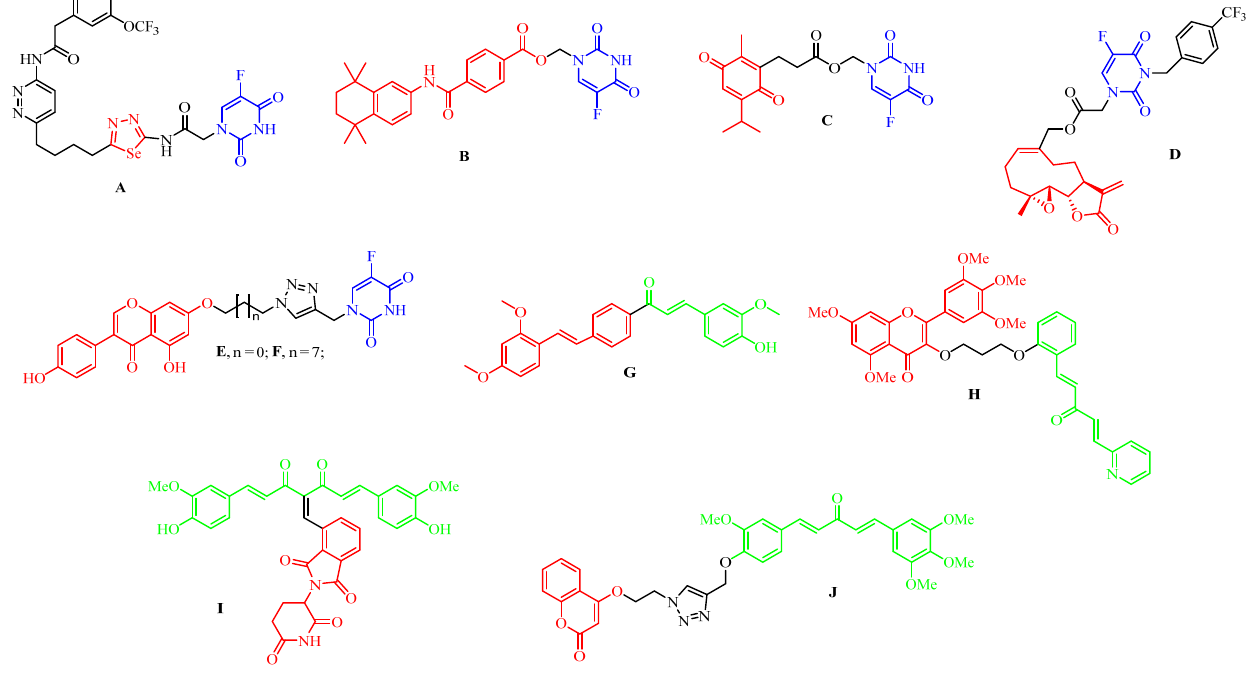
Figure 1. Hybrid molecules derived from 5-FU and curcumin with anticancer activity.